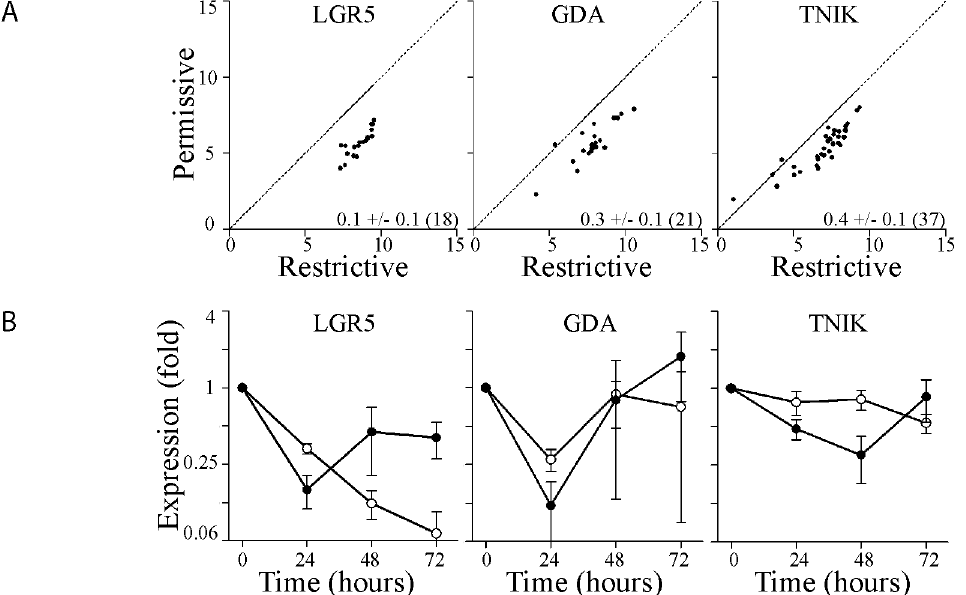
expression were confirmed by qRT-PCR at 24 hours (Fig 6B). However, these decreases in gene expression were not p53-dependent because there was no statistically significant differ- ence between the responses observed in HT29-neo and HT29-tsp53 cells (Fig 6B, P > 0.05 Two-way ANOVA). In contrast, the expression our positive controls, p21 WAF1 and MDM2 dif- fered significantly between cell lines (P < 0.001, Fig 5A). So once again, there was no evidence